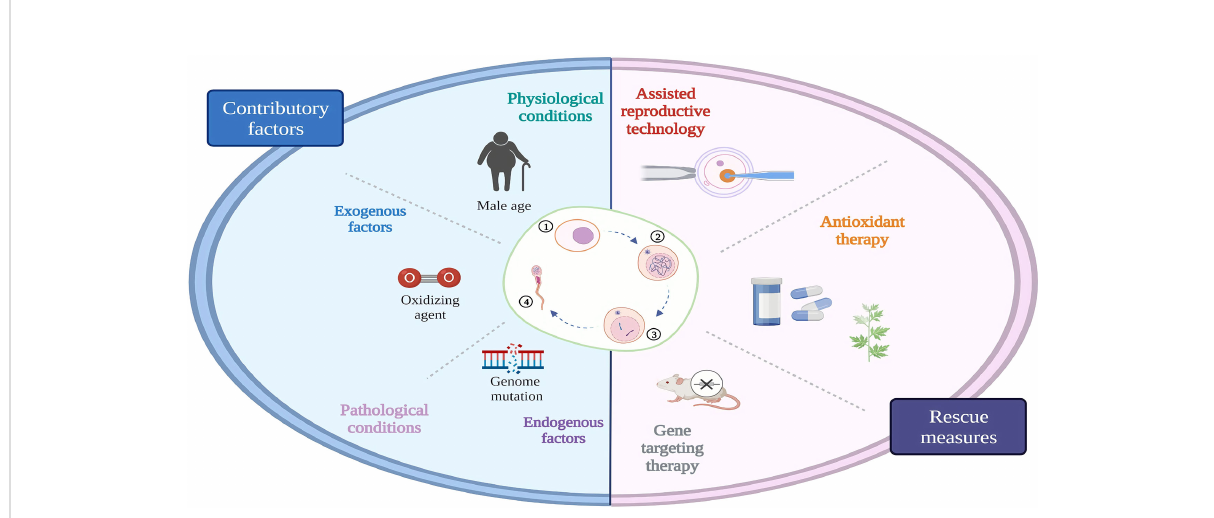
FIGURE 3 Reproductive aging and rescue. Physiological and pathological factors such as aging, smoking caused testicular aging can be rescued by assisted reproductive technology, antioxidant or gene targeting therapy. ① Spermatogonium; ② spermatocyte;spermatid; ④